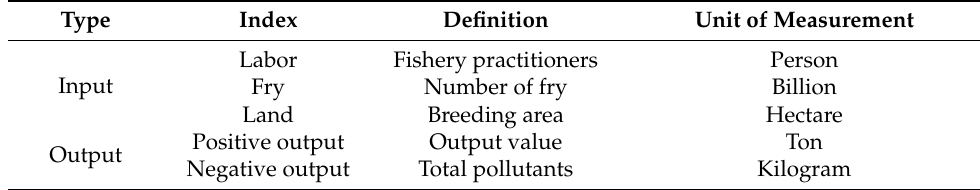
Table 1. Input–output index of